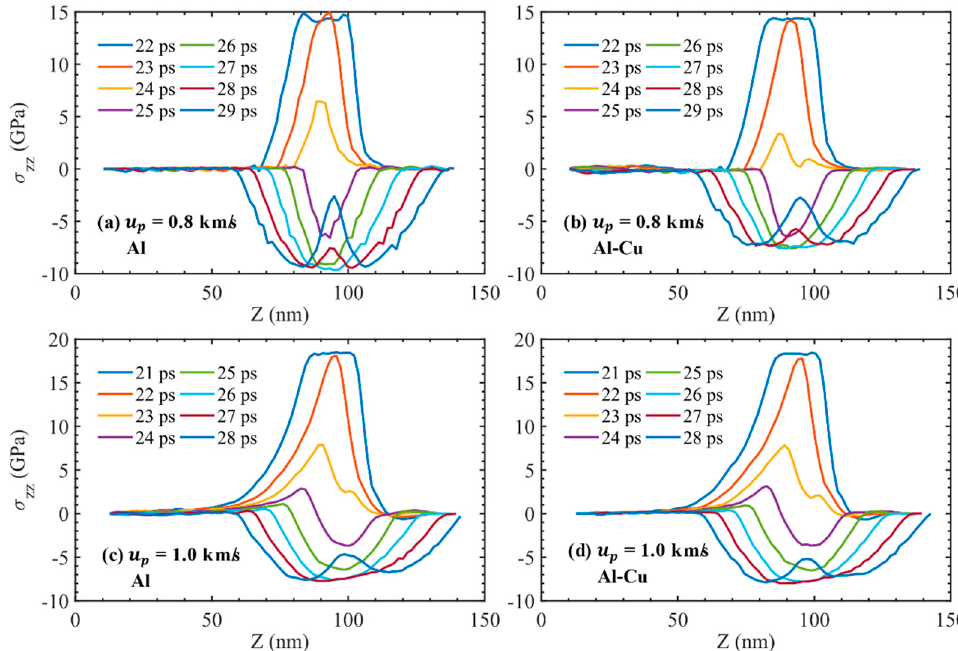
Figure 7. Evolution of longitudinal stress components for pure single crystal Al or the crystal with Cu inclusion at different piston velocities. ( a ) Al, u p = 0.8 km/s; ( b ) Al–Cu, u p = 0.8 km/s; ( c ) Al, u p = 1.0 km/s; ( d ) Al–Cu, u p = 1.0 km/s.